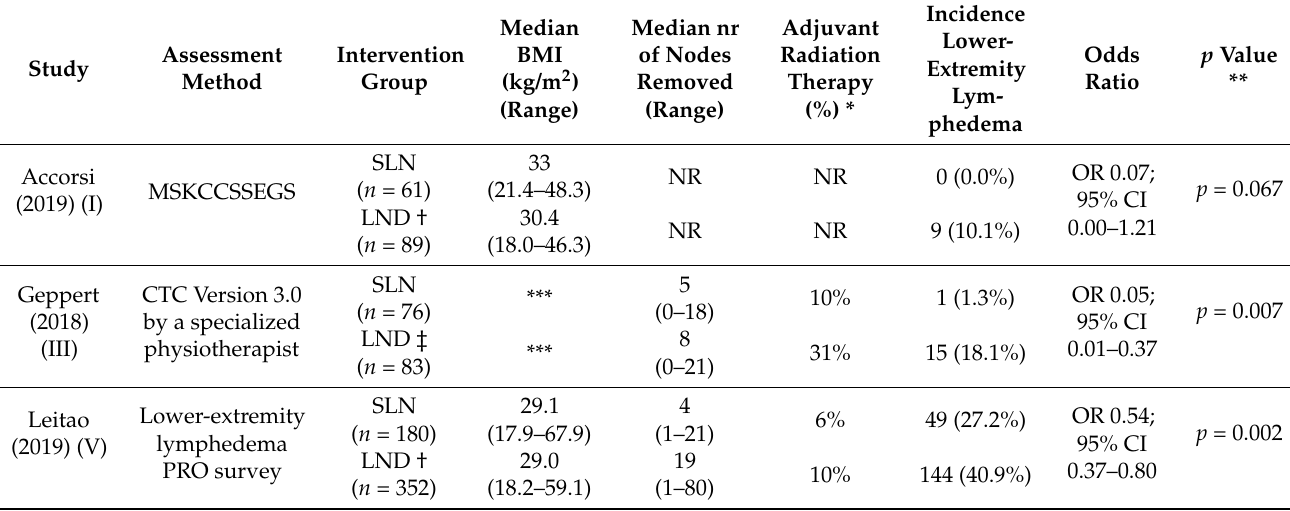
Table 4. The effect of sentinel lymph node biopsy and lymph node dissection on lower-extremity